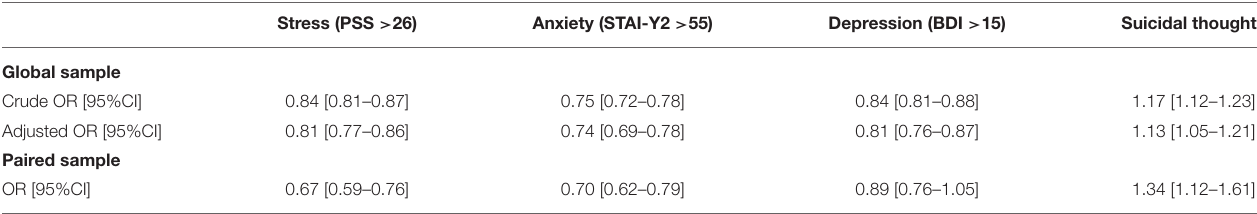
TABLE 2 | Association between no longer being quarantined (T2 vs. T1) and mental health outcomes, in the global and the paired samples: results of bivariate and multivariate analyzes. Stress (PSS >